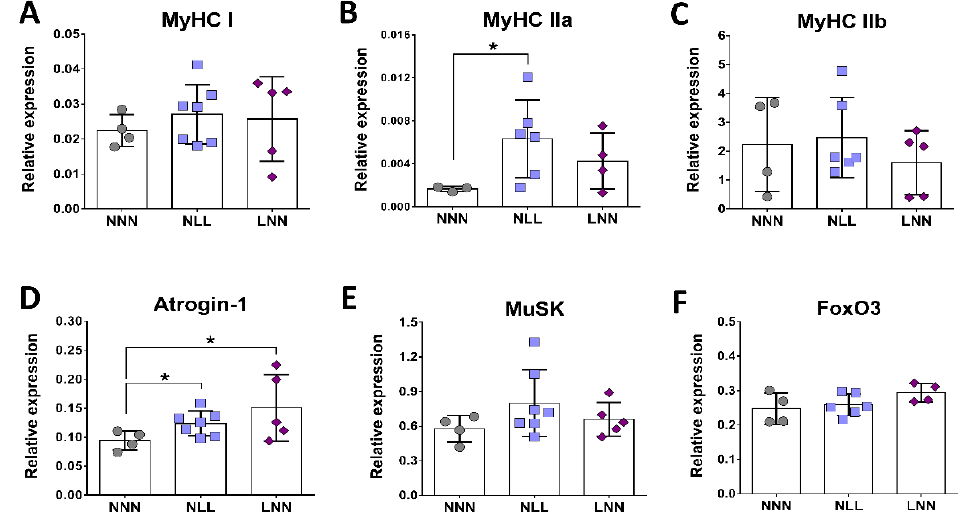
Figure 4. Expression analysis of marker genes for MyHC composition, muscle atrophy and NMJ formation in TA muscle of 12-week-old mice. Mice born from dams fed a normal protein diet and maintained on the same diet (NNN) were used as controls in comparison with mice born from dams fed a normal protein diet during gestation, switched to low protein intake during lactation by cross-fostering and maintained on the low protein diet after weaning (NLL) and mice fed a low protein diet in utero and maintained on normal protein post-weaning until adulthood (LNN). Relative gene expression levels of MyHC-I ( A ), MyHC-IIa ( B ), MyHC-IIb ( C ), Atrogin-1 ( D ), MuSK ( E ) and FoxO3 ( F ). * p ≤ 0.05 (mean ± SD; n = 3–7).